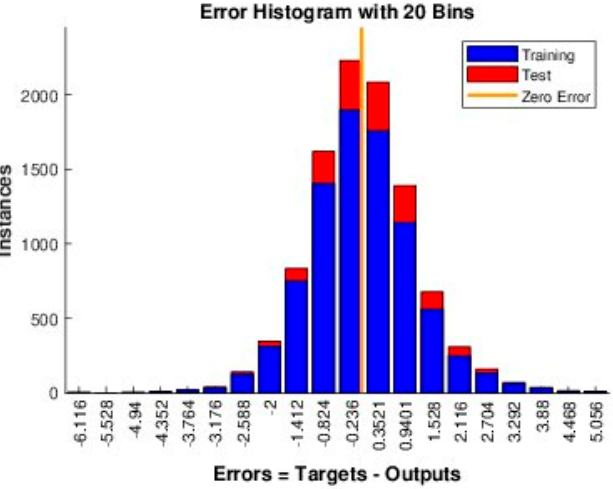
Figure 21. Various training states of neural network (wind velocity forecasting case).